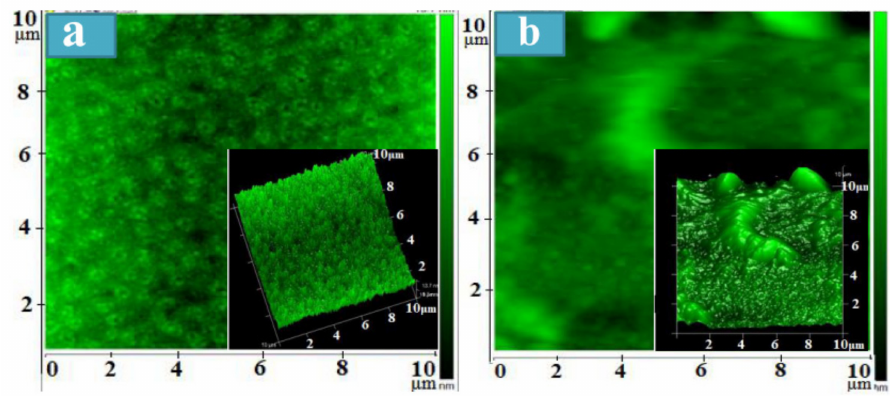
Figure 2. 2D and 3D AFM images of ( a ) pure In 2 O 3 and ( b ) Cr doped In 2 O 3 thin